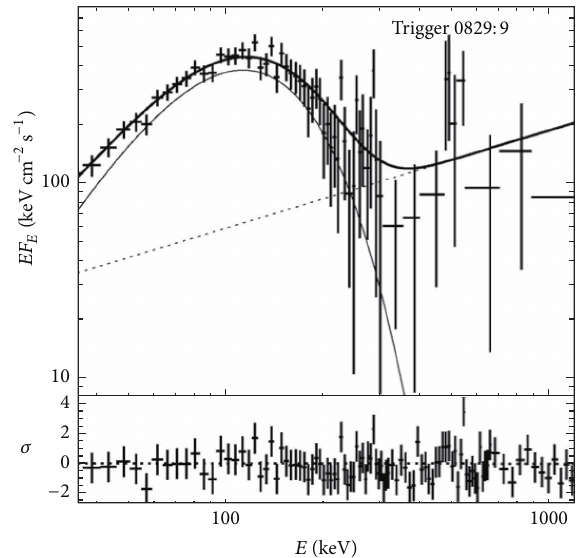
Figure 7: The spectra of GRB110721A are best fit with a “Band” model (peaking at 𝐸 peak ∼ 1 MeV) and a blackbody component (having temperature 𝑇 ∼ 100 keV). The advantage over using just a “Band” function is evident when looking at the residuals (taken from Iyyani et al.